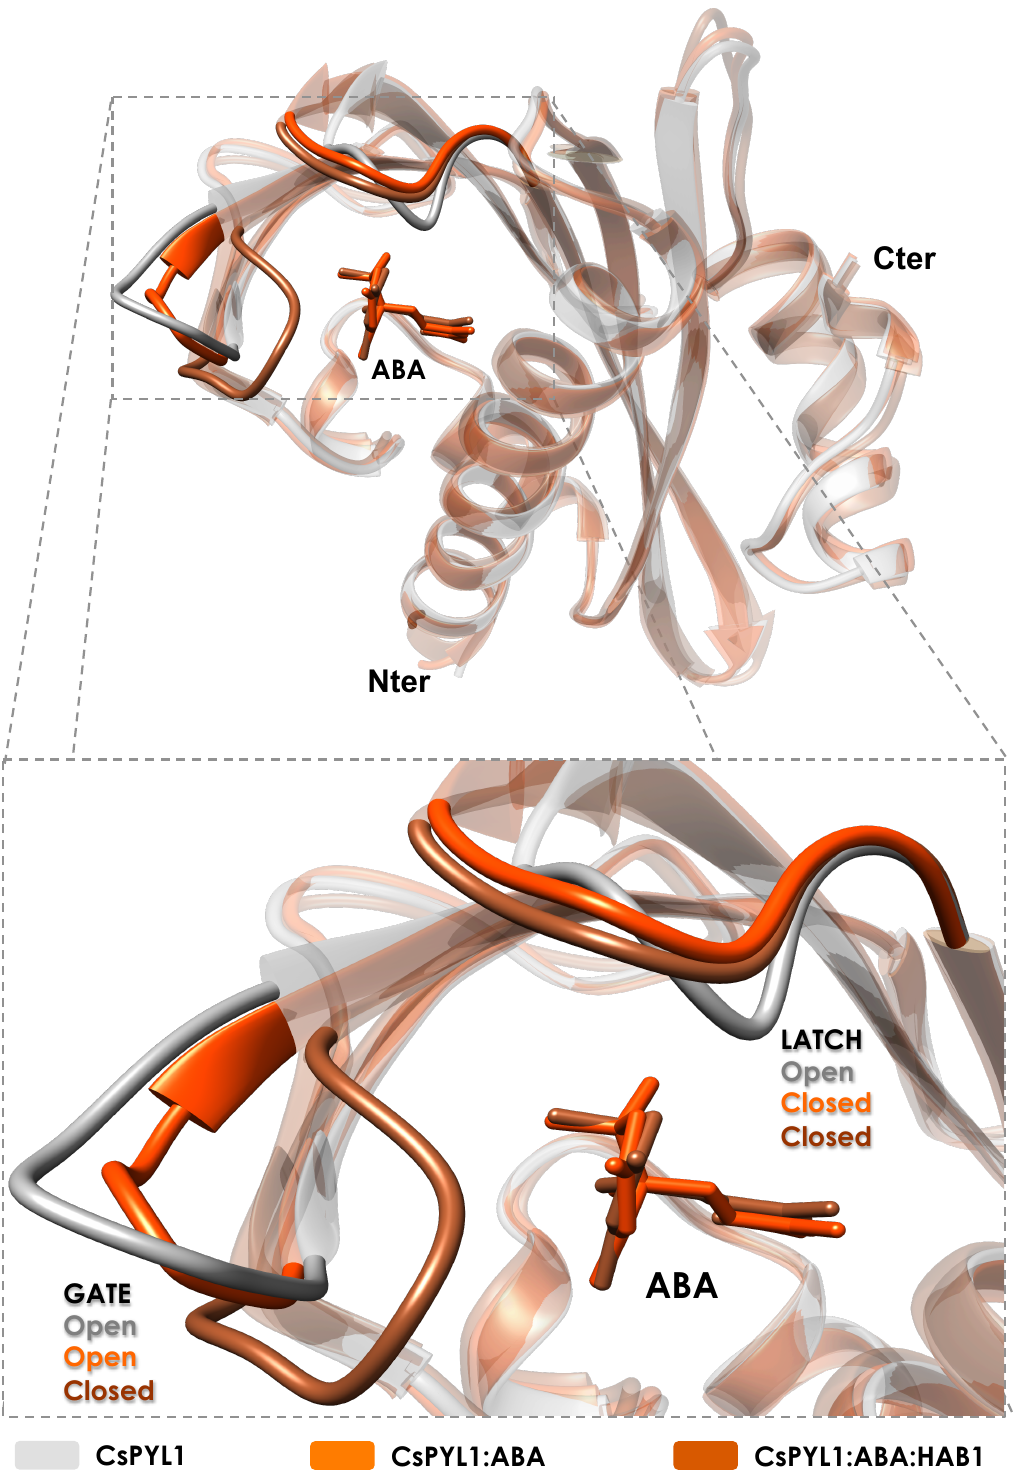
Figure 3. Conformational states of a crop ABA receptor. Superimposition of the CsPYL1 crystal structures corresponding to the apo (PDB ID: 5MMQ), ABA-bound (PDB ID: 5MMX) and ternary complex (PDB ID: 5MN0) forms. The highly conserved latch and gate are highlighted in solid